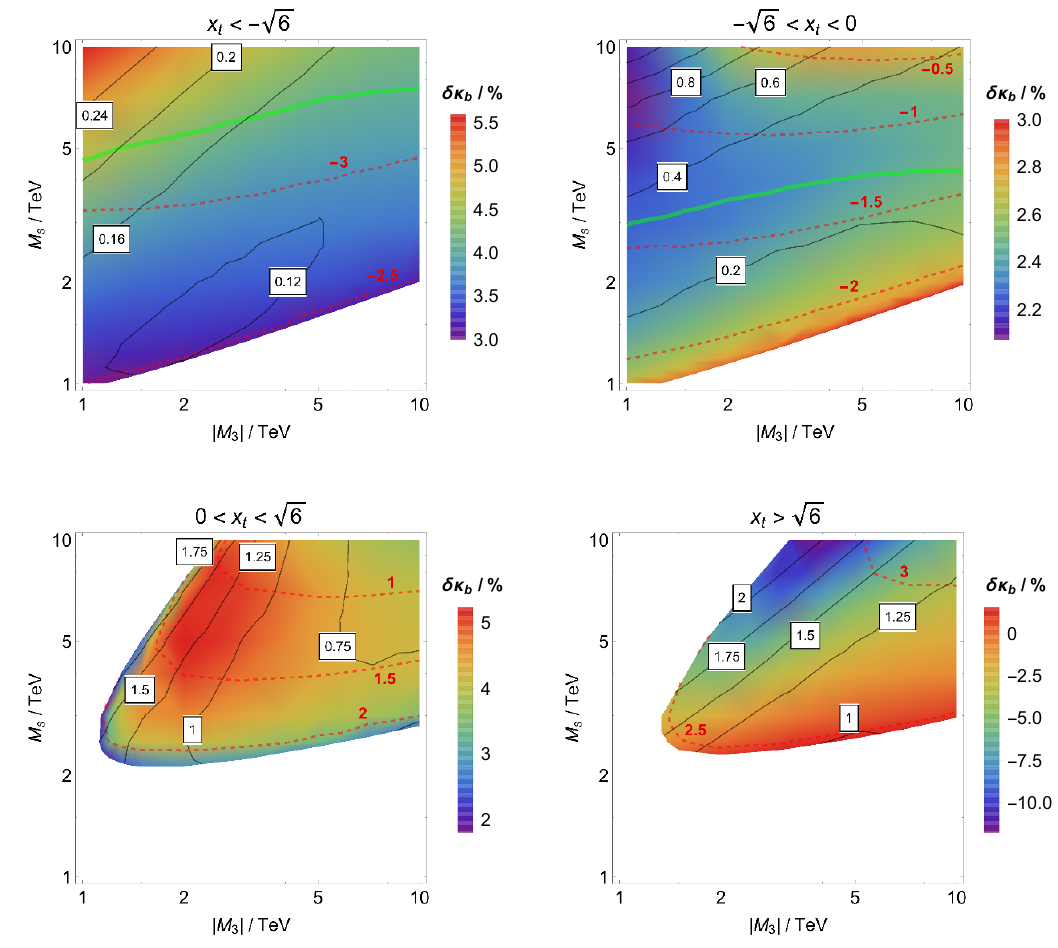
Figure 5 . Variation of (cid:14)(cid:20) b in the region of the j M 3 j - M s plane where a solution exists for exact b - (cid:28) Yukawa uni(cid:12)cation, on each x t branch, with M (cid:8) = 1 TeV and tan (cid:12) = 50. Superimposed are contours of (cid:22)=M s (black) and x t (red dashed). Light green curves in the x t < 0 plots correspond to the 1 TeV Higgsino dark matter benchmark. Direct superpartner searches probe lower mass regions of the parameter space (with j M 3 j . 2 TeV potentially already excluded at the LHC depending on decay kinematics), while precision Higgs measurements can be more sensitive to higher mass regions where (cid:14)(cid:20) b is enhanced by one-loop